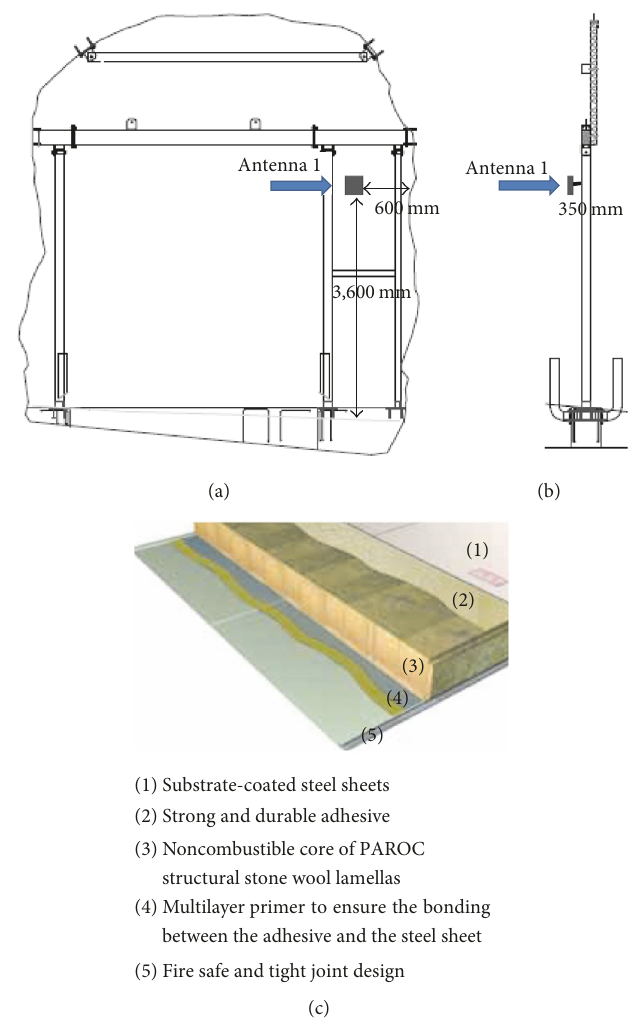
Figure 8: Firewall construction at pole 95 from the front (a) and from the side (b) and the firewall PAROC-element structure